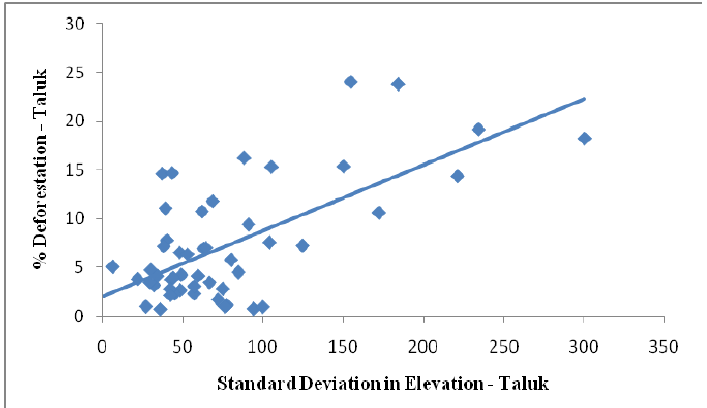
Figure 12b. Relationship between variation in elevation and the distribution of deforestation for